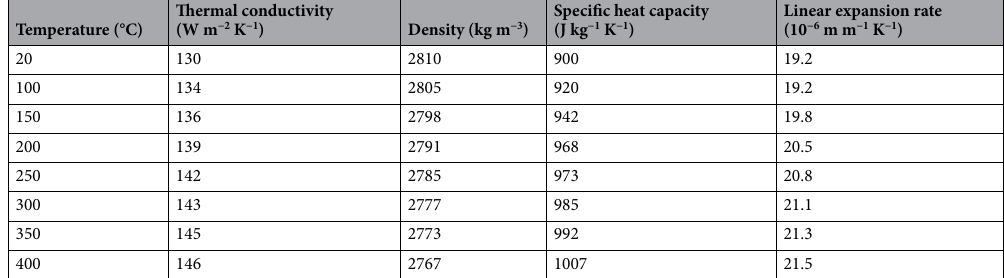
Table 4. Thermophysical parameters of the piston body material at different temperatures.